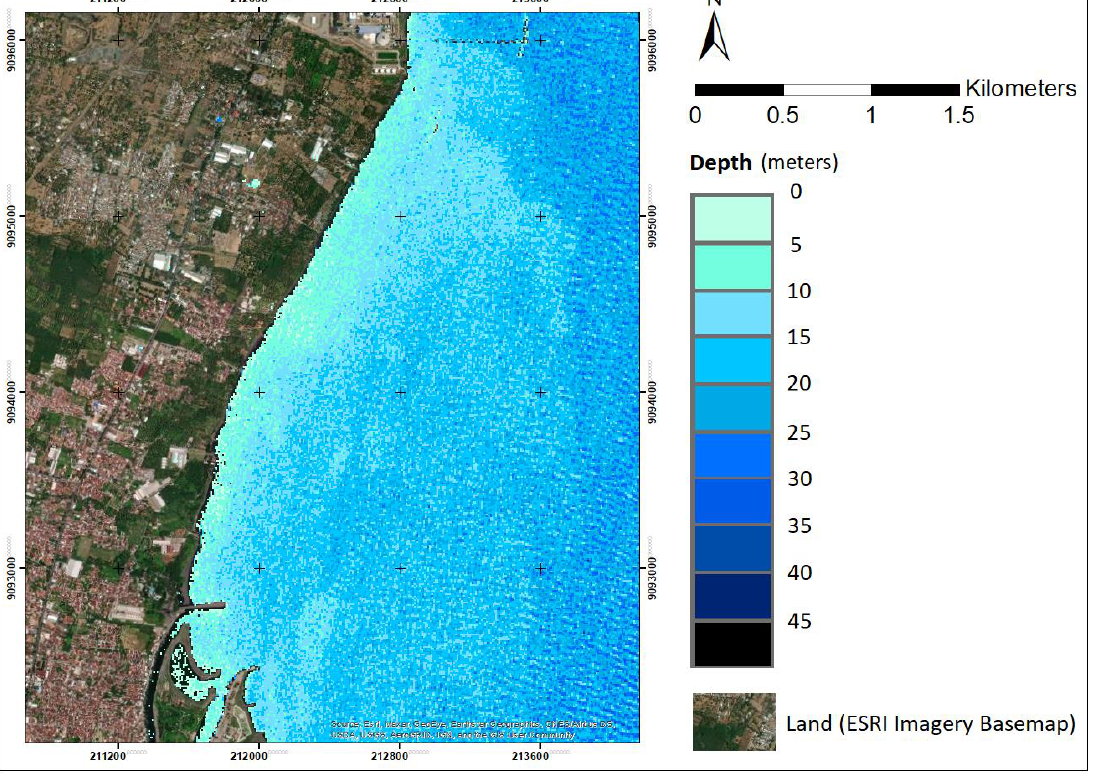
Figure 2 . Water Depth Estimation Result from SDB, Band 2 and Band 3